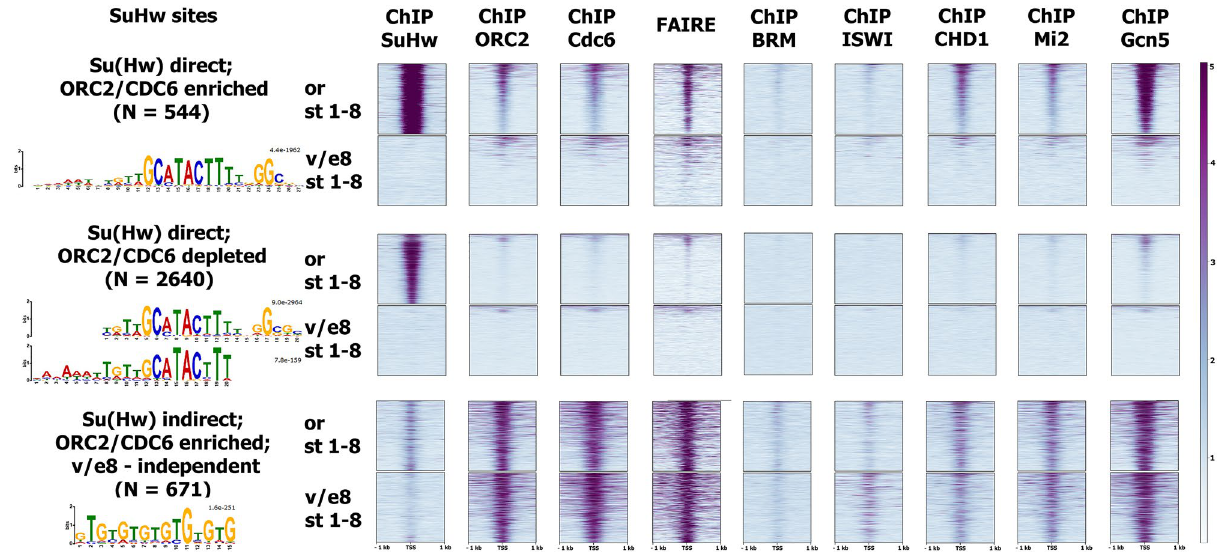
Figure 5. Clustering analysis confirms the existence of replicational SBS subclass. Heatmap showing ChIP- Seq signals for various proteins or FAIRE-Seq signal surrounding cluster 1 (“Su(Hw) direct; ORC2/CDC6 enriched”), cluster 2 (“Su(Hw) direct; ORC2/CDC6 depleted”) and cluster 3 (“Su(Hw) indirect; ORC2/CDC6 enriched; v/e8-independent”) SBSs ± 1 kb in in the wild-type and su(Hw) v / E8 ovaries containing egg chambers stages 1–8. MEME-generated consensus sequences for the cluster 1–3 SBSs are shown on the left of the heatmap (E-values for corresponding motifs are